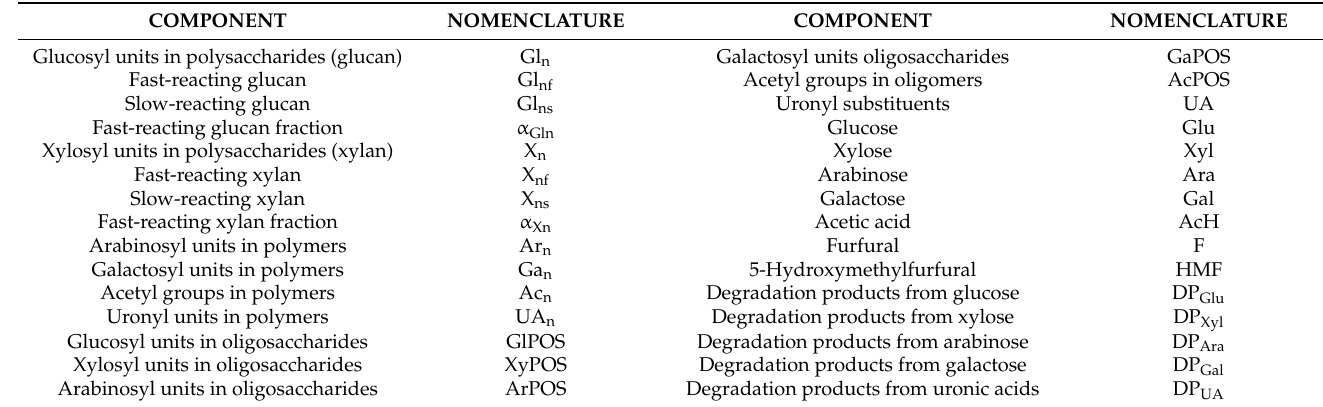
Table 1. Nomenclature employed in the kinetic modeling of M × G autohydrolysis.